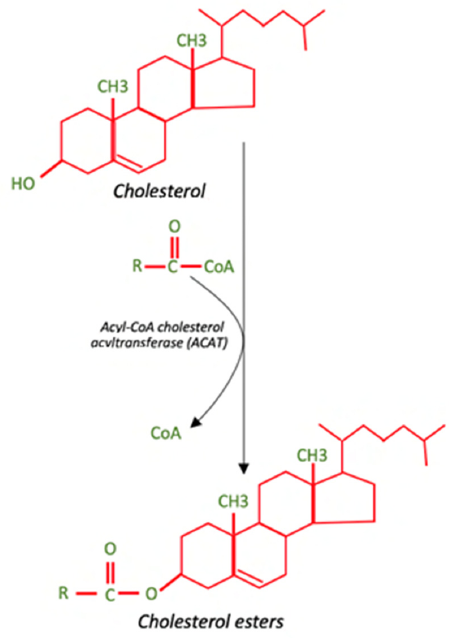
Figure 1. Chemical structure of cholesterol and cholesterol esters.